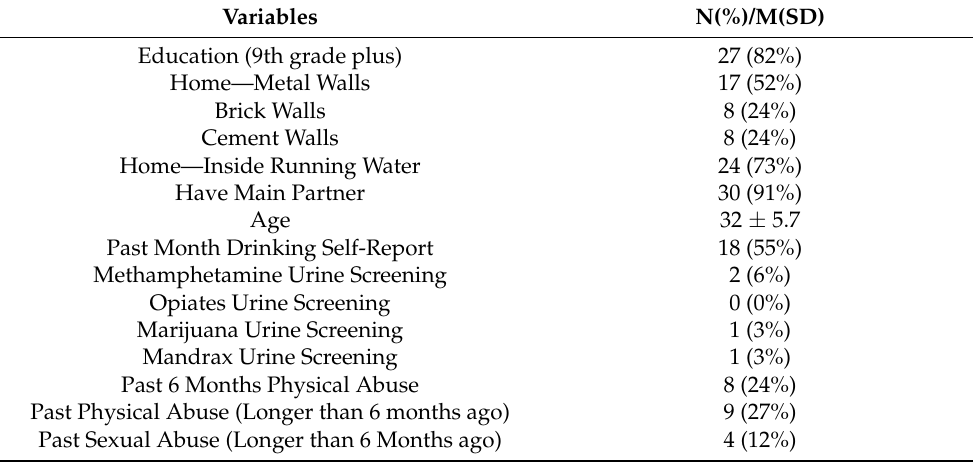
Table 1. Participant baseline characteristics of women who were pregnant at the baseline assessment (N =